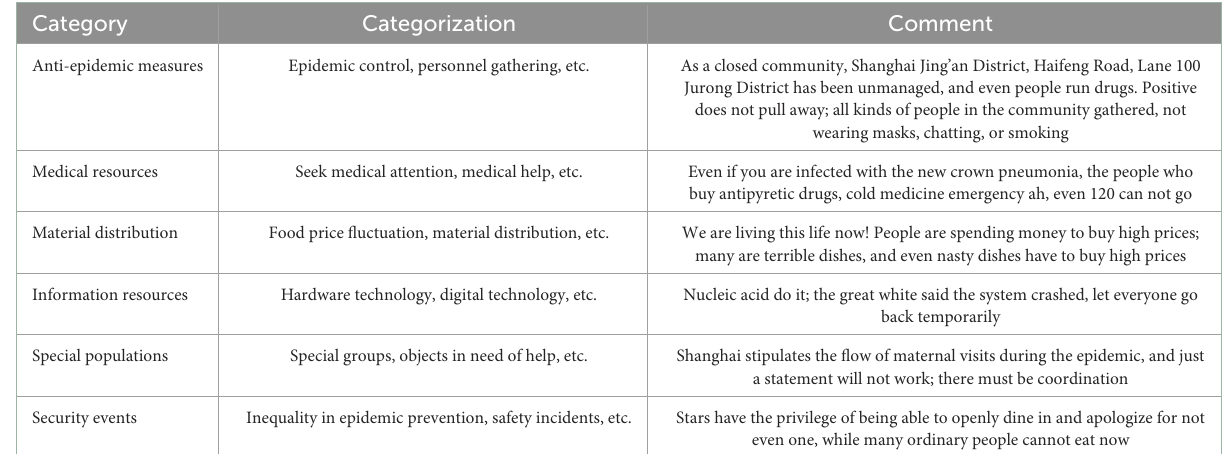
TABLE 1 Partial categorization process. Category Categorization Comment Anti-epidemic measures Epidemic control, personnel gathering, etc.